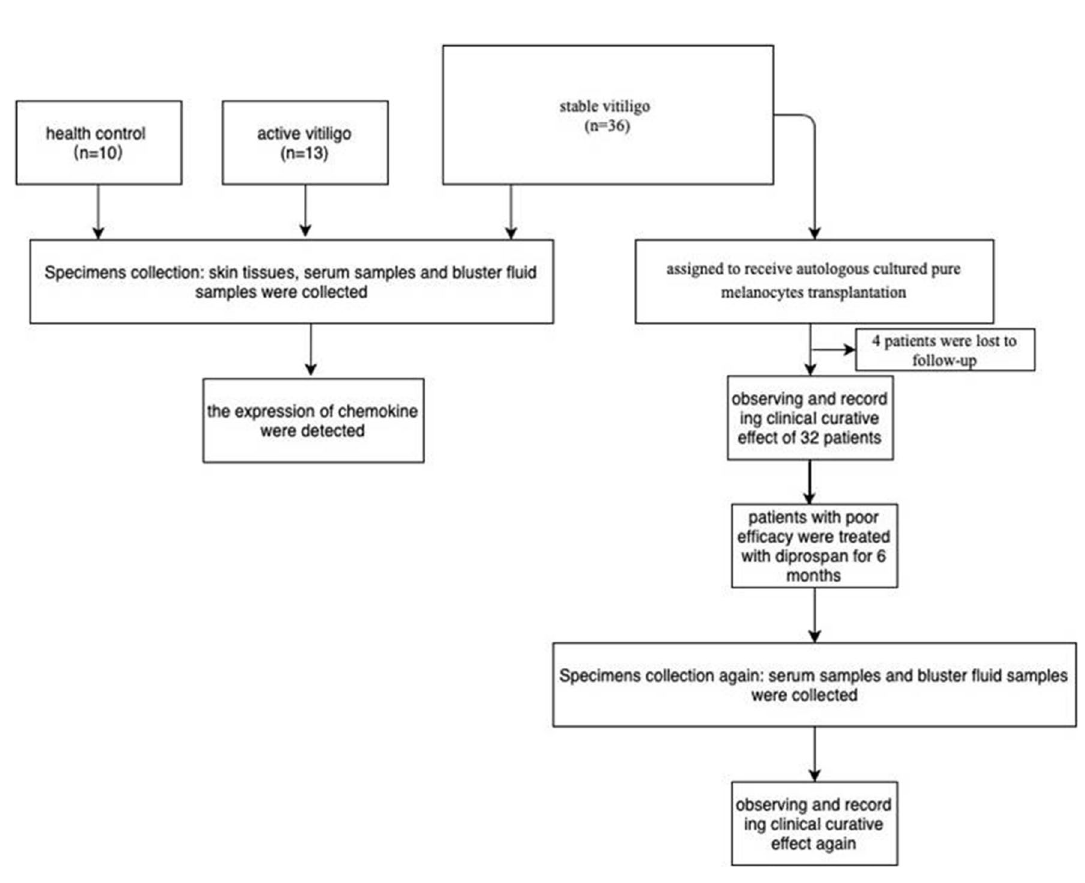
Figure 1. Flow chart of the